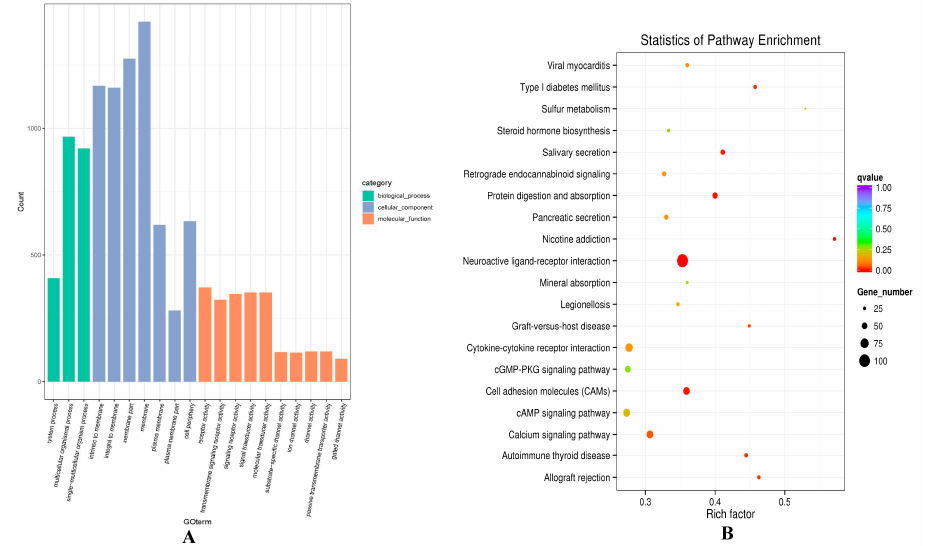
Figure 5. GO and KEGG analysis of differentially expressed lncRNAs target mRNA through co-expression analysis in hair follicle. ( A ) The enrichment GO terms between small waves and straight wool. ( B ) The enrichment pathways between small waves and straight wool.